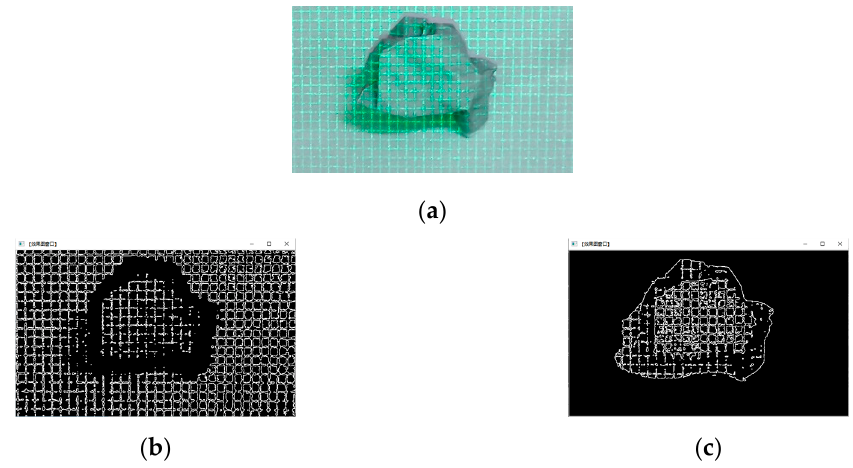
Figure 24. ( a ) The irregular obstacle that was similar in color to the background; ( b ) the irregular contour of the obstacle is very vague.